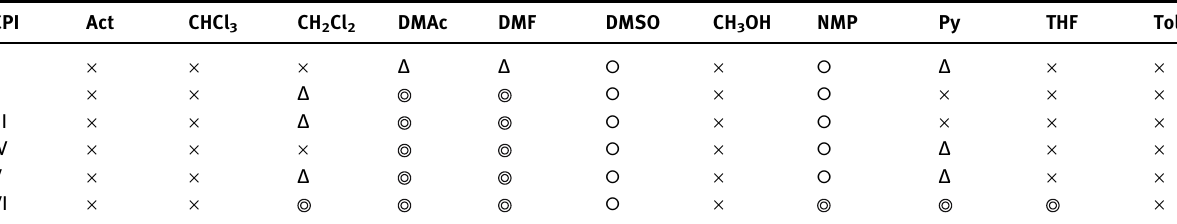
Table 6: Solvent tests of CPI fi lms obtained from the CHDA monomer